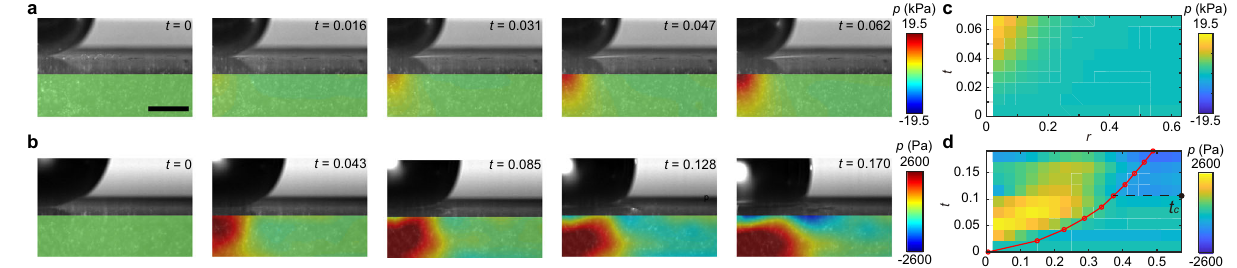
Fig. 6 Pressure distribution of solid-sphere impact and drop impact. a , c The temporal evolution of the pressure p ( r , z , t ) and the kymograph of the surface pressure p ( r , z = 0, t ) of solid-sphere impact. The diameter and the impact velocity of the steel sphere are D = 3.16 mm and U = 0.49 m/s. b , d The temporal evolution of p ( r , z , t ) and the kymograph of p ( r , z = 0, t ) of drop impact. D = 3.49 mm and U = 2.97 m/s. The red line in d indicates the position of the turning point. The time when the negative pressure emerges t c = 0.106 is also indicated. Scale bar in ( a ) is 1 mm. Note that the pressure scale is kPa for the solid-sphere impact and Pa for the drop impact.